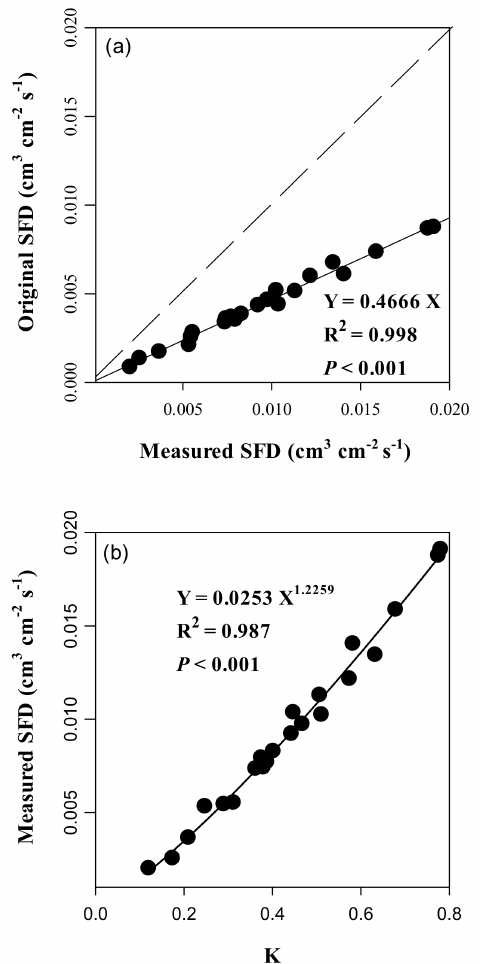
Figure 4. ( a ) A comparison of the SFD values estimated by the Granier equation of the original parameters ( a = 0.0119, b = 1.231) and measured via the gravimetric method. The dashed line is the 1:1 line; ( b ) the relationship between the SFD values measured by the gravimetric method and the dimensionless sap flow index K for Chinese